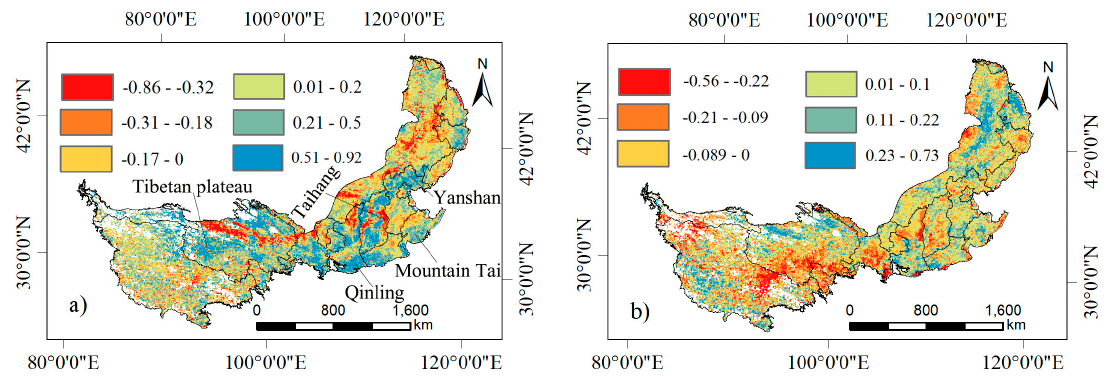
Figure 6. Partial correlation analysis between vegetation and temperature ( a ), precipitation ( b ) from 1982 to 2015.